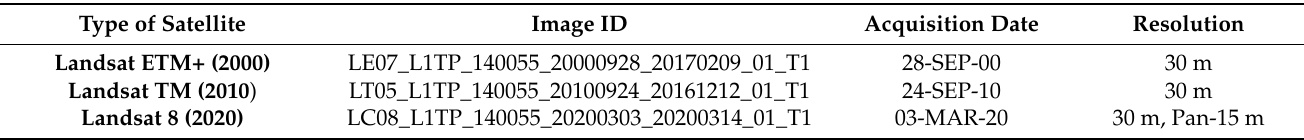
Table 3. Details of satellite imagery